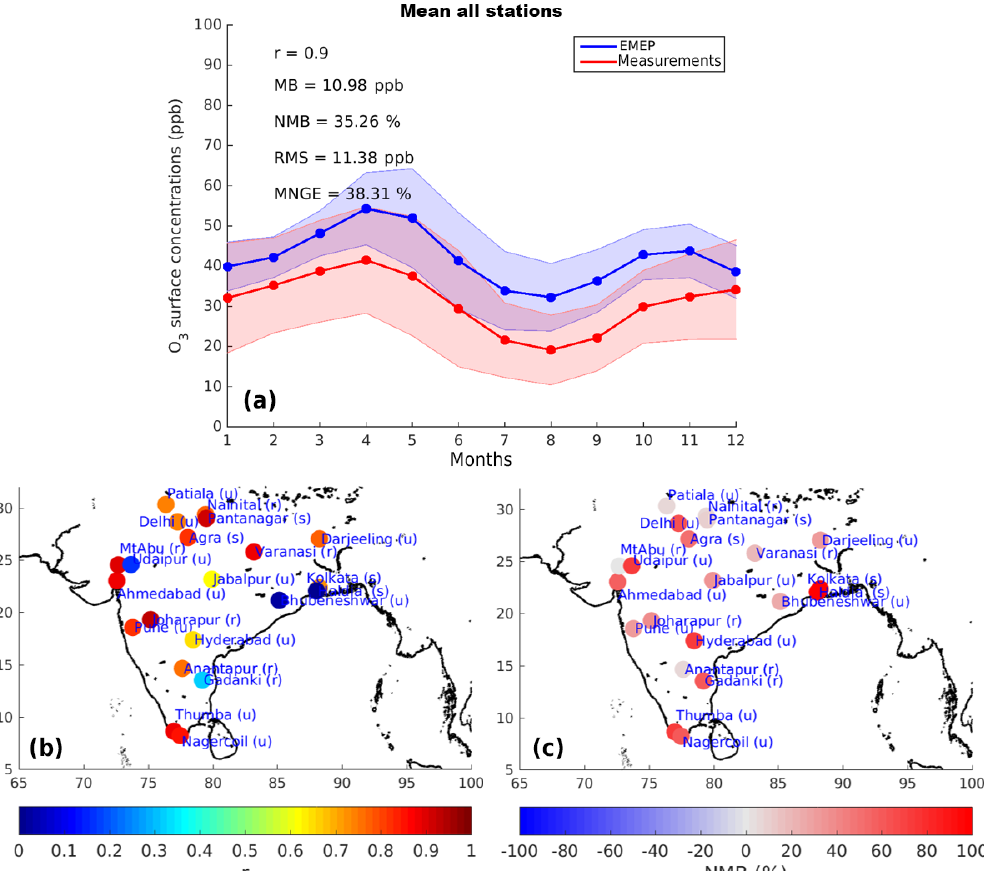
Figure 2. (a) Monthly surface O 3 mean concentrations for the 22 stations (red) and EMEP (averaged over the period of simulation) (blue). EMEP concentrations are collocated to each station. The shade error corresponds to the standard deviation. The correlation coefficient ( r ), the mean bias (MB), the normalized mean bias (NMB), the root mean square (RMS) error, and the mean normalized gross error (MNGE) are provided. (b) Correlation coefficient for each site. (c) Normalized mean bias for each site. The type of station is given by a letter in parentheses ( u , urban; s , suburban; r ,